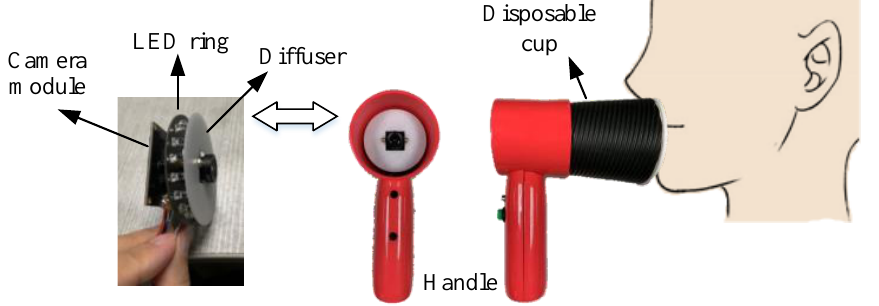
Figure 6. System prototype and the experiment for human tongue detection. Using the two captured frames and the recovery method, we obtained the multispectral images of the tongue. Through some pre-processing, we cut out the surrounding region and only preserved the interest region of the tongue. Figure 7a shows the two frames captured and Figure 7b shows some of the tongue images with different wavebands.